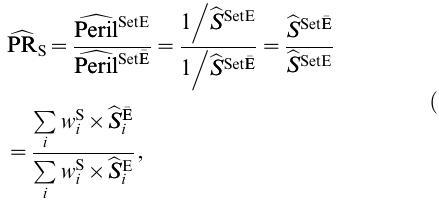
where the ‘Set X’ operator dictates that the exposure status of each and every subject in the population is set to X, and the weight,